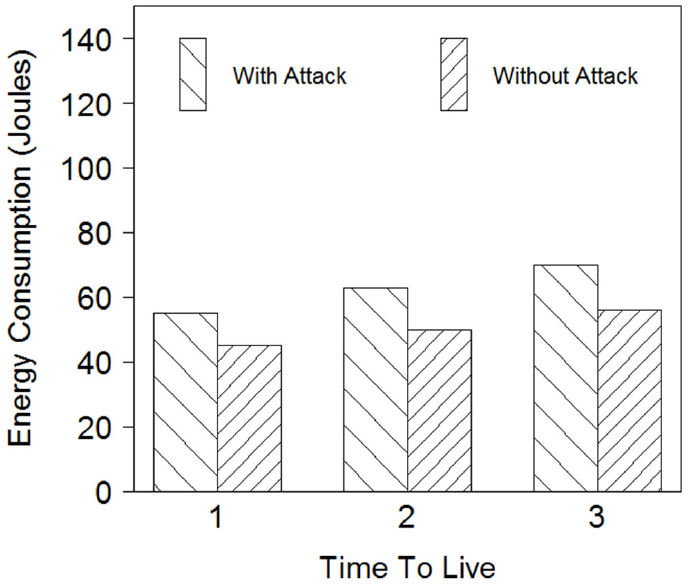
Figure 13. Time to live vs. energy .